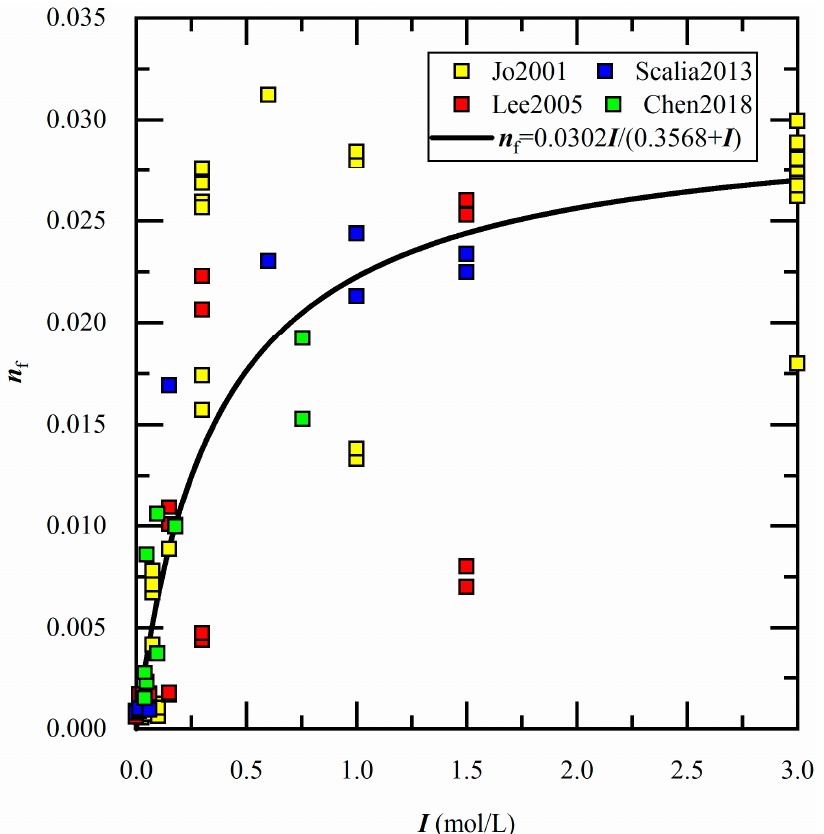
Figure 6. Relationship between final mobile porosity and Ionic strength.